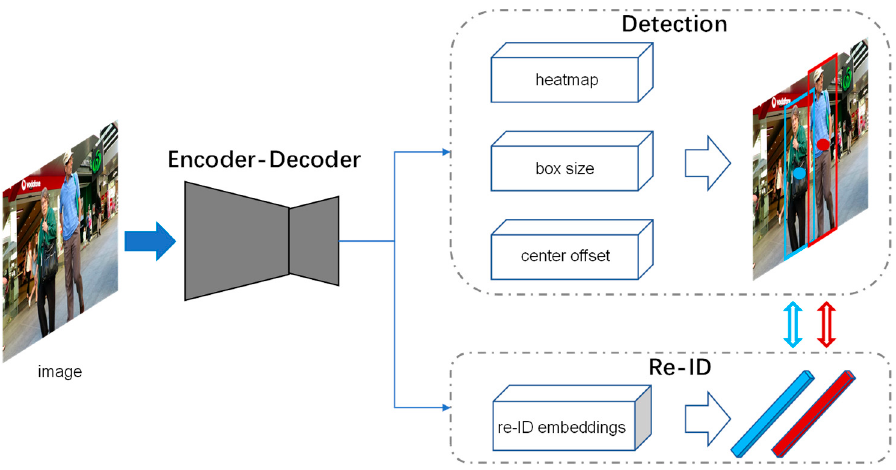
Figure 3. Overview of the one-shot tracker CSMOT.